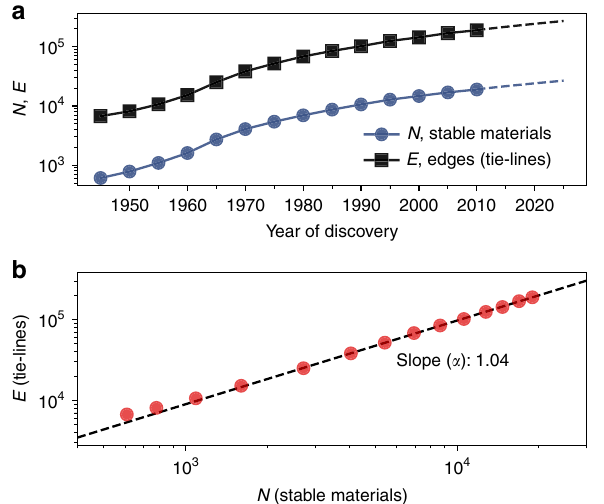
Fig. 2 Evolution of the size of the materials stability network. a Time evolution of the number of stable materials (i.e., nodes), N , and tie-lines (i.e., edges), E , and ( b ) how the number of nodes and tie-lines vary with respect to each other. A tie-line is included in the evolving network only after both nodes it is connecting to are identi fi ed as discovered. Dashed lines in ( a ) are extrapolations of N and E from the available data (markers and solid lines) by fi tted quadratic polynomials. Dashed line in ( b ) is a linear fi t to the data (circles). Fits performed in both panels exclude the fi rst four times steps to obtain fi ts that are more representative of more recent times. A plot of the number of stable materials discovered each year as a function of time is also available in Supplementary Fig. 1